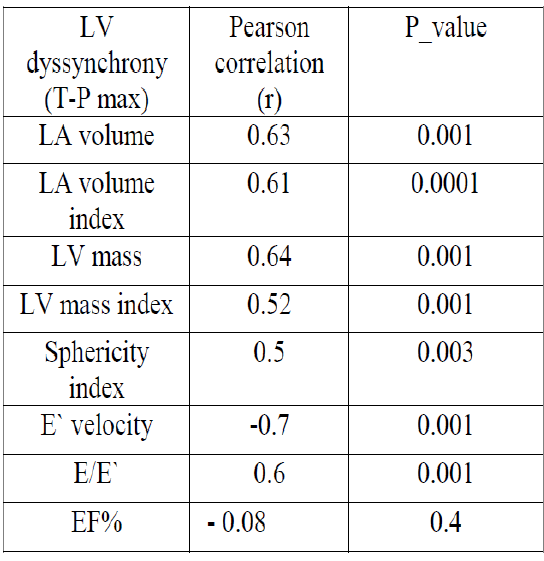
Figure 1 show the diagram of positive correlation between LV dyssynchronyand LA volume index which mean greater LV dyssynchrony was observed withincreasing LA volume index (r = 0.61, p = 0.001) .